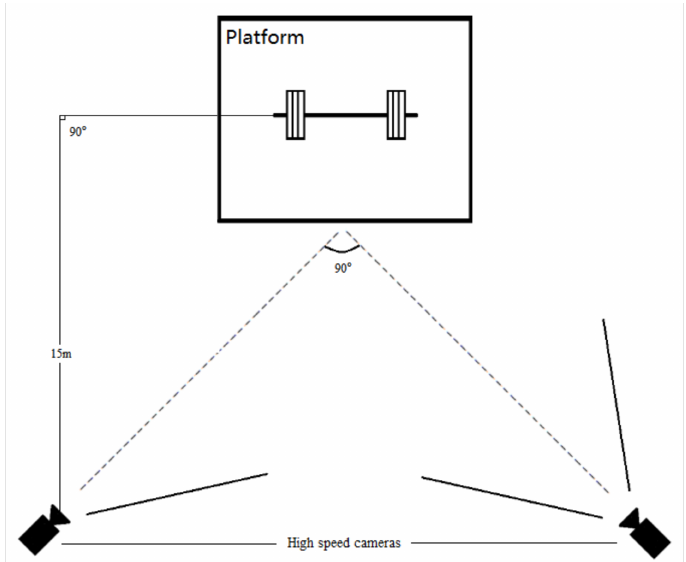
Figure 1. Schematic of the motion capture setup with two high-speed